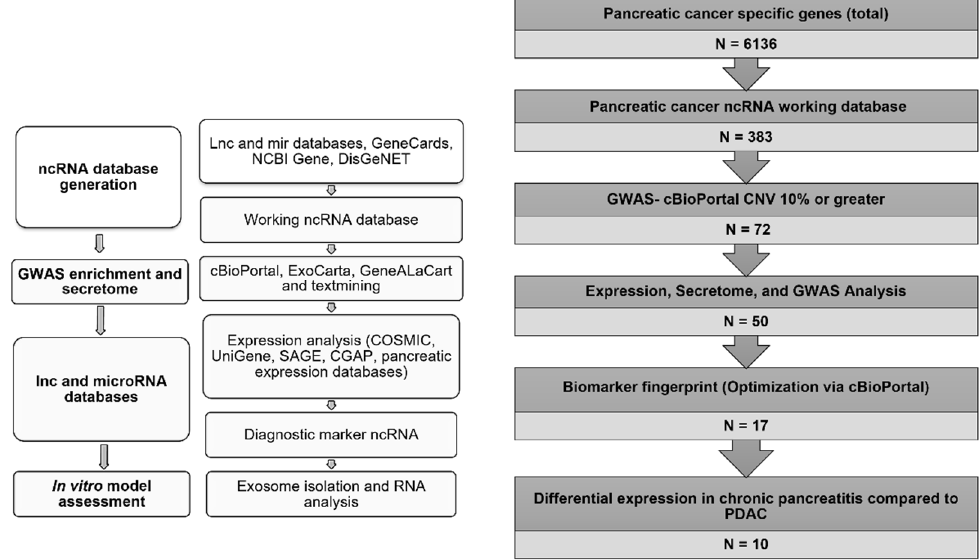
Figure 1. Workflow for the identification and analysis of exosomal microRNA for PDAC diagnosis. Whole gene lists associated with PDAC were downloaded from the lnc and miRNA databases as well as GeneCards, NCBI Gene, and DisGenNET in order to identify as many PDAC-associated ncRNAs as possible (N = 6136). Protein-coding genes were then removed in order to isolate only ncRNAs (N = 383). This provided the basis for our ncRNA database. cBioPortal was used to identify genetic alterations of ncRNAs across patient data in order to determine the most attractive targets for diagnostic potential (N = 72). The expression databases (COSMIC, UniGene, SAGE, CGAP, and PED) and secretome tools (ExoCarta and GeneALaCart) were then accessed to determine if any of the remaining MIRs were secreted and exhibited changes in expression in PDAC to better determine the most reliable exosomal targets for PDAC detection (N = 50). Additional optimization using cBioPortal with putative secreted exosomal MIR markers (CNV 15% or greater) was used (N = 18). Comparison of MIR expression in chronic pancreatitis compared to PDAC was then used as the final metric for candidate MIRs for diagnostic potential (N = 10). The MIRs identified in this manner were considered diagnostic markers for further analysis in cell culture models.